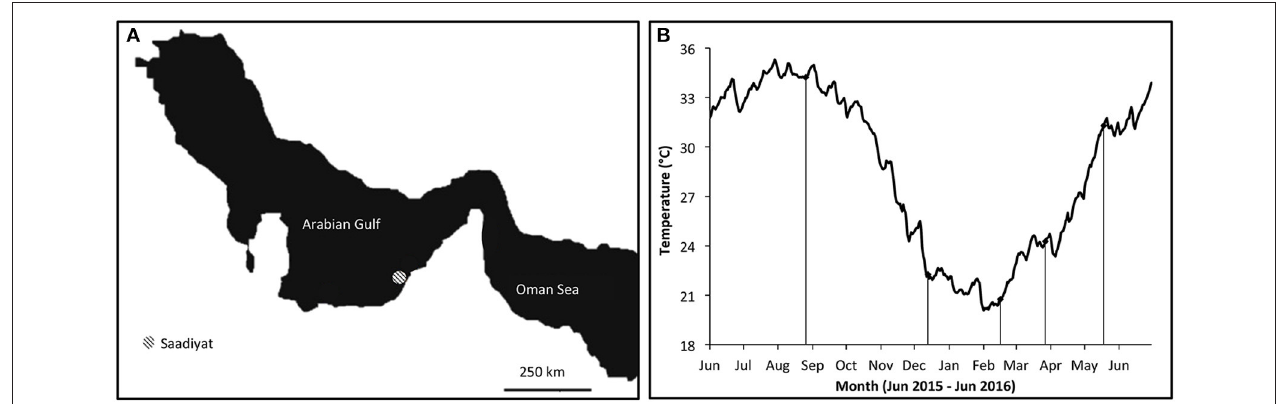
FIGURE 1 | (A) Map of the Saadiyat reef study location (adapted from Howells et al., 2016). (B) Mean daily seawater temperatures on Saadiyat reef. Lines indicate collection periods.